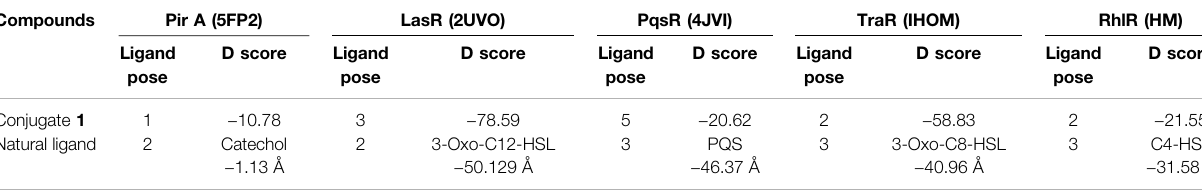
TABLE 1 | Docking scores (kcal/mol) of conjugate ( 1 ) and respective natural ligand with Pir A, LasR, PqsR, TraR, and RhlR receptors. Compounds